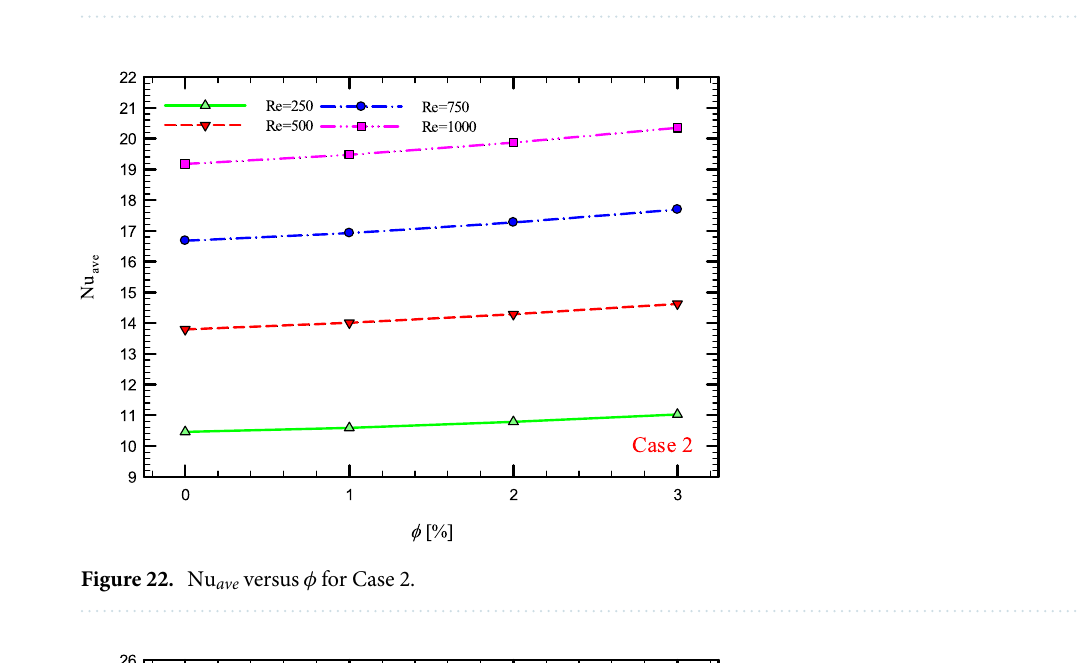
Figure 21. Nu ave versus φ for Case 1.